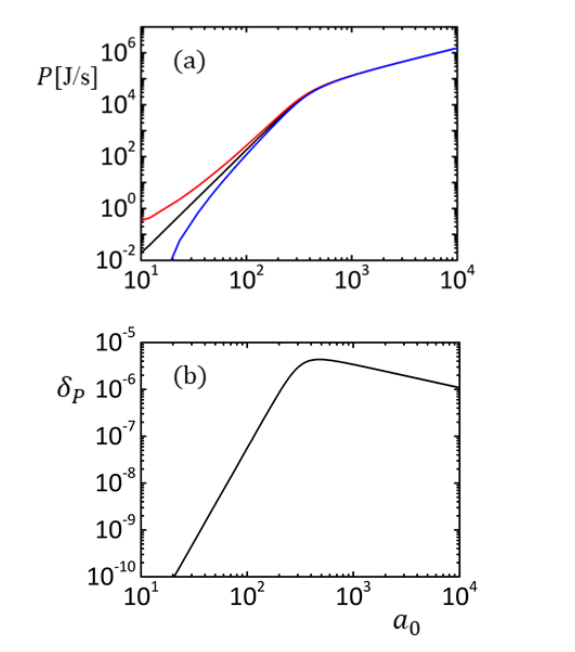
Figure 4. ( a ) The radiation power from the charged particle under a static magnetic and a rotating electric field as a function of electric field intensity a 0 for different magnetic field intensities of b 0 = 10 (red), b 0 = 0 (black), and b 0 = − 10 (blue). ( b ) The relative difference of radiation power evaluated using the LAD equation with and without the Schott